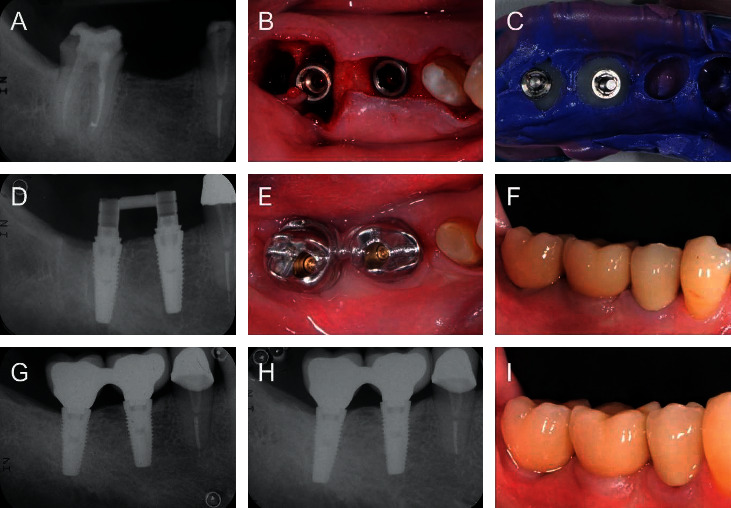
Patient subjected to partial tooth extraction and placement of two Neoss ProActive Tapered implants in the lower right molar area. (a) Presurgical situation. (b) Implant surgery. (c) Impression taking. (d) Provisional restoration. (e) Framework try-in. (f) Definitive prosthesis. (g) 6-month follow-up. (h) 1-year follow-up. (i) More than one year of clinical follow-up.